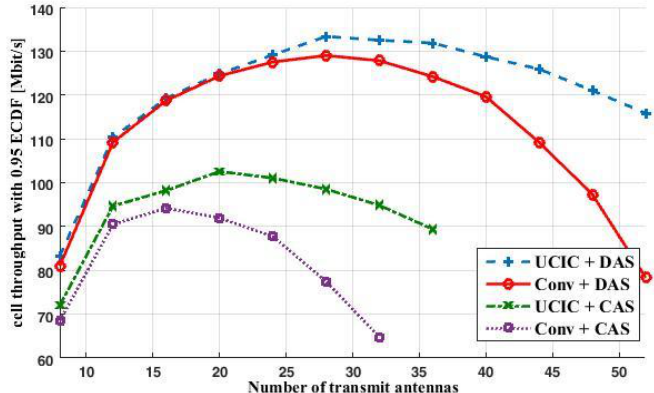
Figure 8. Compare system throughputs of four scenarios: (i) Massive Multi-Input Multi-Output (MIMO) with CAS and conventional limited feedback technique (Conv + CAS), (ii) Massive-MIMO with CAS and proposed UCIC strategy (UCIC + CAS), (iii) Massive-MIMO with DAS and conventional limited feedback technique (Conv + DAS), and (iv) Massive-MMO with DAS and UCIC (UCIC + DAS), where 8 bits are assigned for CSI feedback.